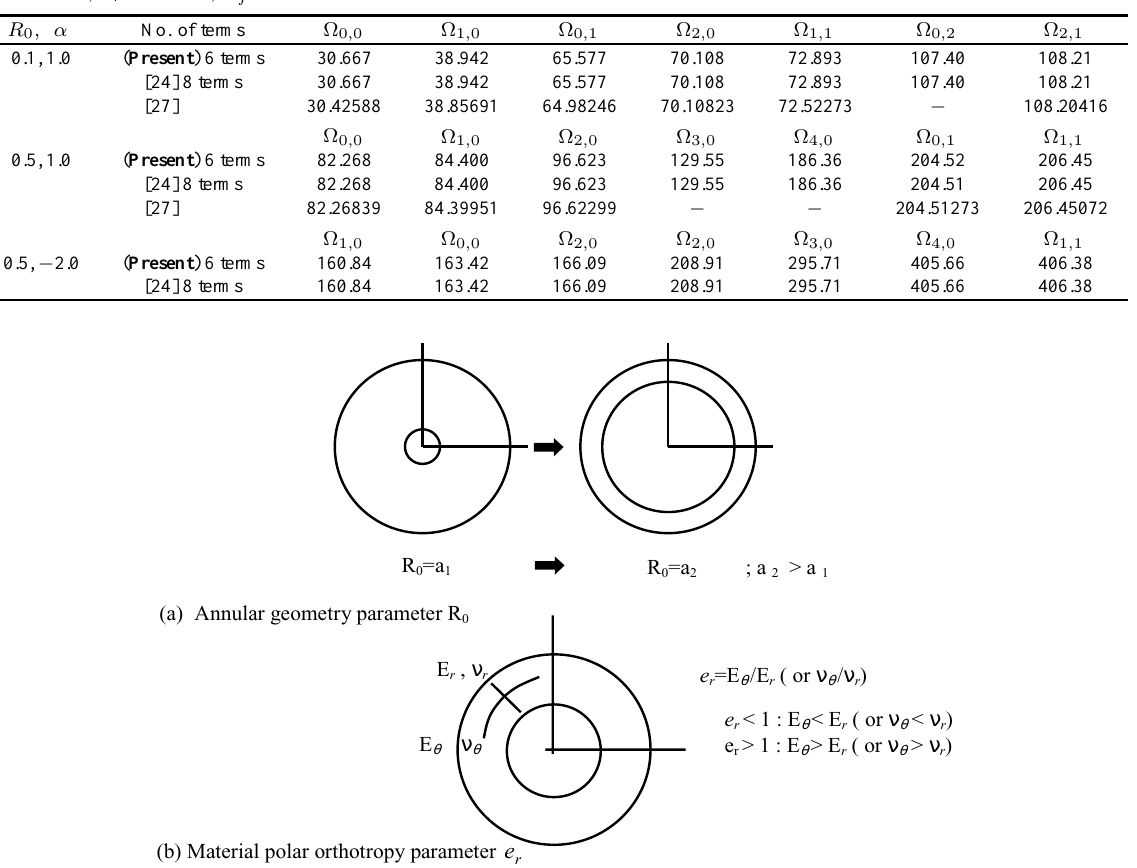
Table 5 Comparison of Ω m,n for polar orthotropic annular plates of linearly varying thickness with clamped Peripheries when β = 0 ,e r = 50 ,